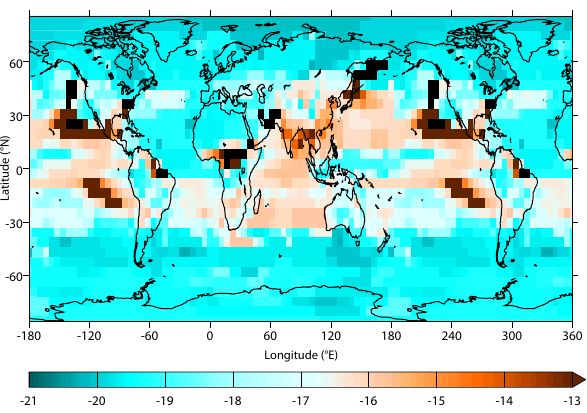
Fig. 5. Annual mean temperature difference (in ◦ C) between 9ka BP wrt 21ka BP for a 100-year sample. Color scale is in ◦